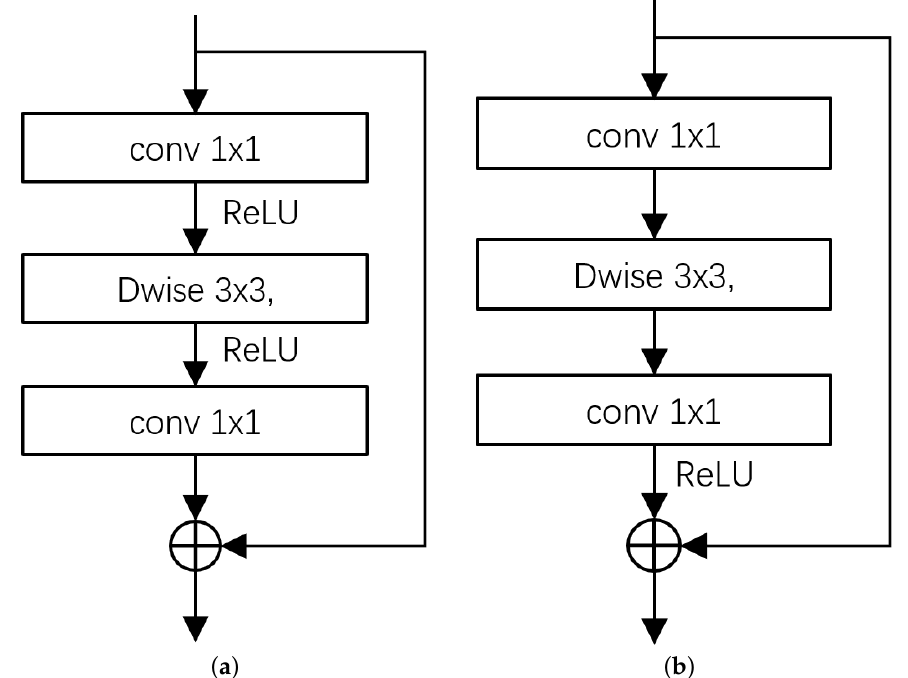
Figure 2. Invert linear bottleneck [24] and Single linear bottleneck comparison diagram. ( a ) Invert linear bottleneck. ( b ) single linear